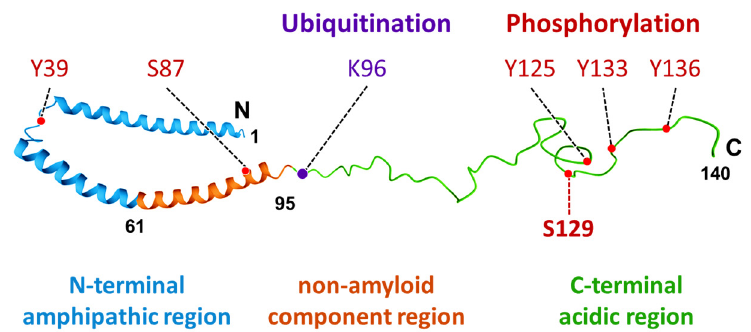
Figure 1. Structure and summary of post-translational modification sites of α -synuclein. The schematic represents α -synuclein protein [28] with the N-terminal amphipathic region, non-amyloid component region, and C-terminal acidic region. Phosphorylation sites are indicated in red letters, and ubiquitination is shown in purple. The indicated Ser129 phosphorylation site is the potential region mostly associated with α -synuclein-induced neurodegeneration.